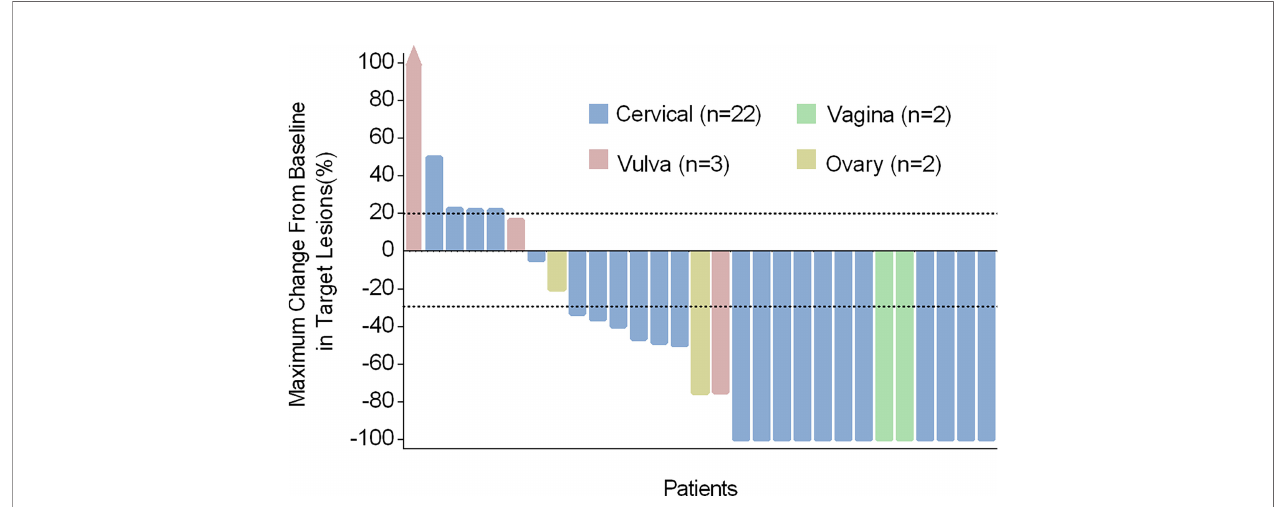
FIGURE 2 | Characteristics of treatment response in different cancer types. Maximum change from baseline in the sum of target lesion diameters. Tumor reduction (bars) corresponds to maximum change from baseline in target lesions and not to the best overall response.